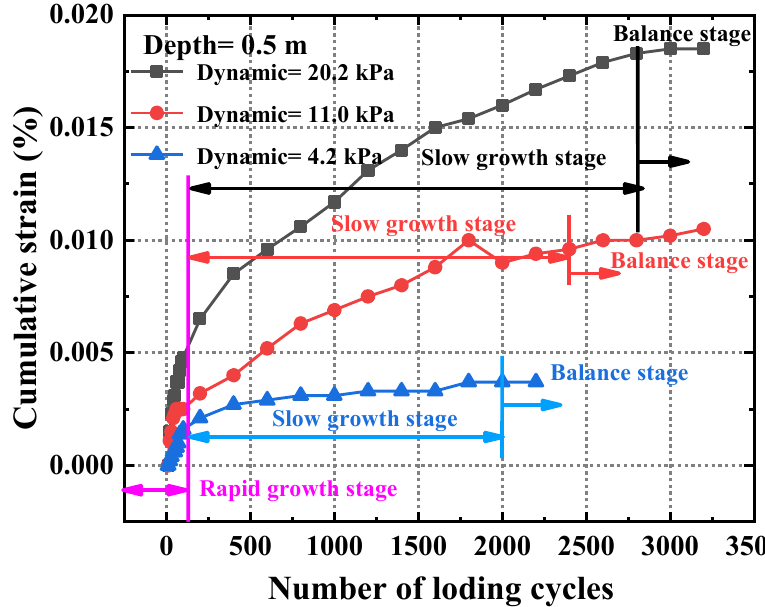
Figure 8. Cumulative strain at subgrade depth of 0.5